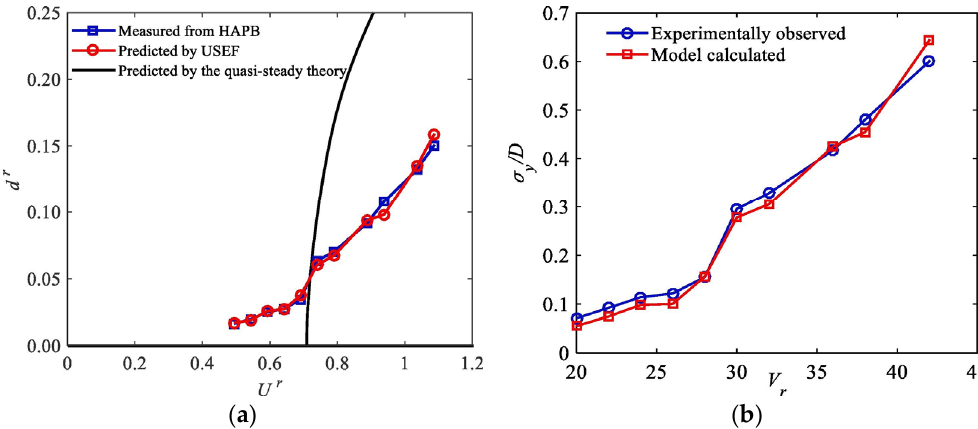
Figure 18. Comparison of predicted amplitudes of oscillation with experimental results and those predicted by the classical quasi-steady theory: ( a ) Galloping response predicted by quasi-steady theory and measured unsteady self-excited force (USEF); ( b ) galloping response calculated by developed model [25].